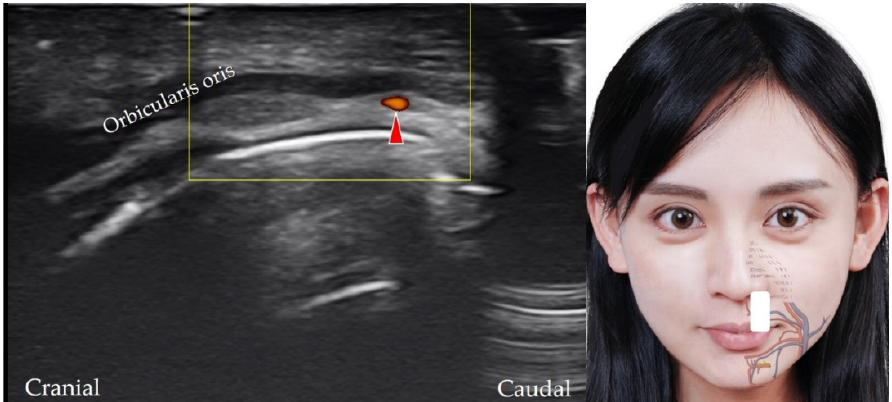
Figure 11. Power Doppler ultrasound imaging of the superior labial artery (red arrowheads) . White square , footprint of the ultrasound transducer.